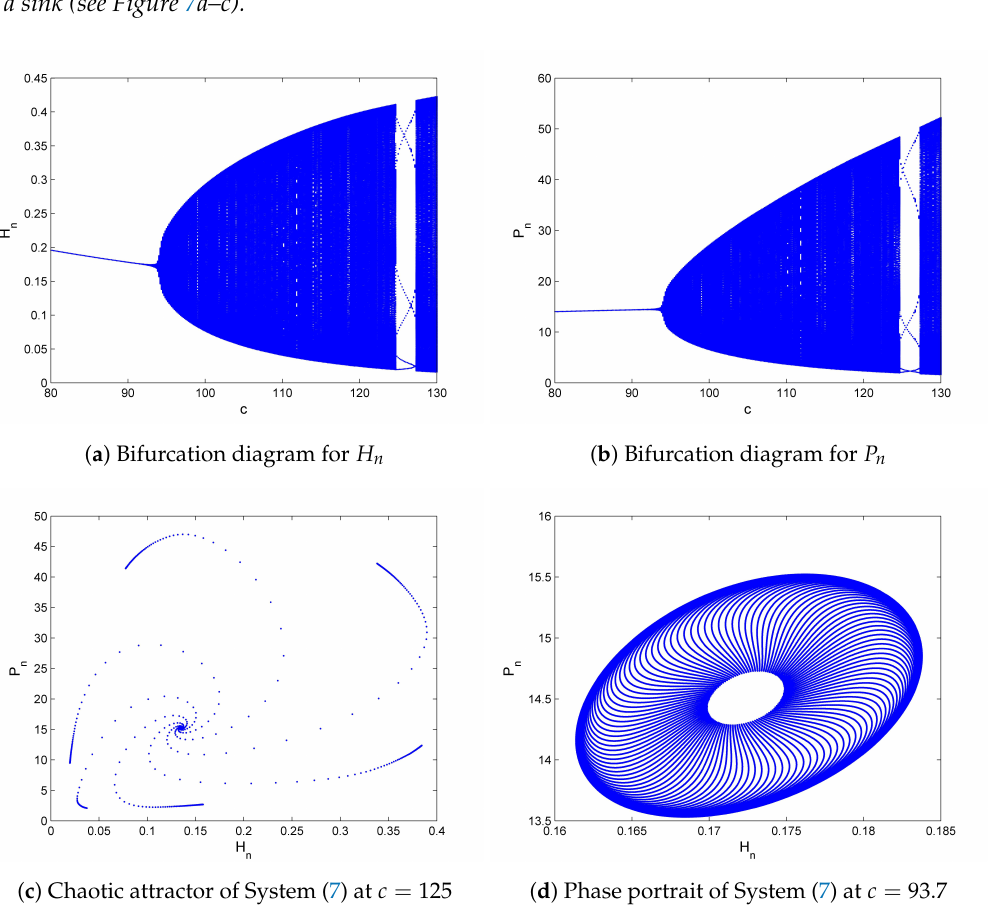
Figure 5. Bifurcation diagrams and phase portraits for System (7) with ( r , q , m , k ) = ( 12.5,0.6,0.5,15.5 ) , and c ∈ [ 80,130 ]